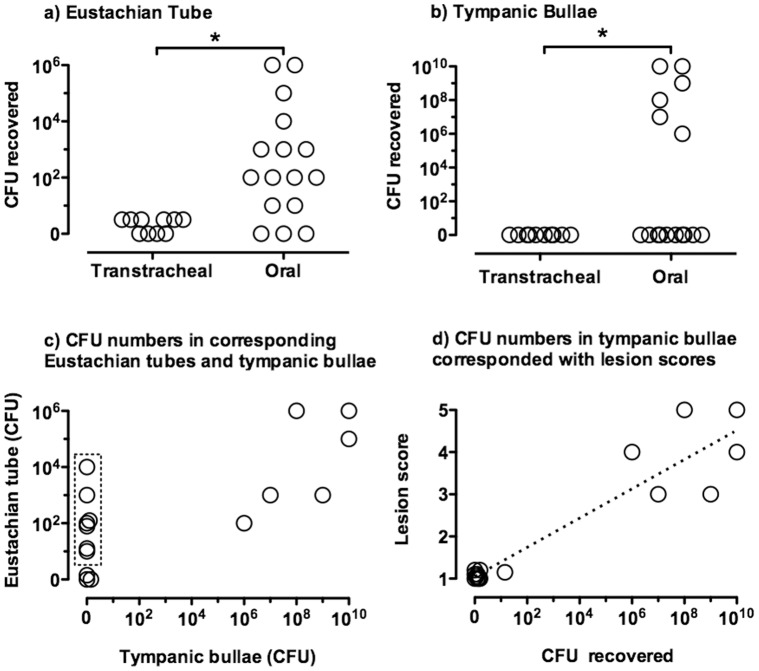
The numbers of M. bovis recovered in the Eustachian tubes and tympanic bullae were dramatically higher in orally-inoculated than in transtracheally-inoculated calves.A t 14 days after oral- (N = 8) or transtracheal-inoculation of calves (N = 5), mycoplasma numbers in corresponding a) Eustachian tubes and b) tympanic bullae were determined (left and right sides are shown separately for each inoculated calf). Mycoplasmas were not recovered from any tissue of any control calf (N = 8). (data not shown). High numbers of mycoplasmas were recovered from the ears of several animals in the mycoplasma-inoculated group. c) In all animals where mycoplasmas were recovered from the tympanic bullae, organisms were recovered from the corresponding Eustachian tube; however, there were several animals (outlined in dashed box) where organisms were recovered from the Eustachian tubes and not the corresponding tympanic bullae. Data represent all orally (N = 8) and transtracheally (N = 5) inoculated calves, with left and right sides shown separately for each calf. d) Ears with the highest lesions scores in tympanic bullae also had high lesion scores in corresponding Eustachian tubes. Data represent all orally (N = 8) and transtracheally (N = 5) inoculated calves, with left and right sides shown separately for each calf For visual purposes, tissues with identical scores have been shown with values slightly offset. Asterisks “*” denotes a significant difference between groups (P≤0.05).